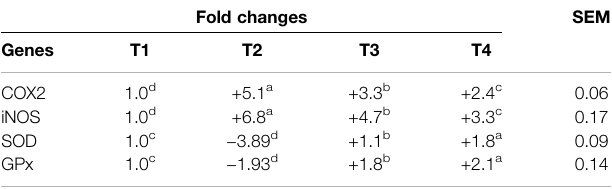
TABLE 7 | Gene expression analysis of the mice received different treatments.